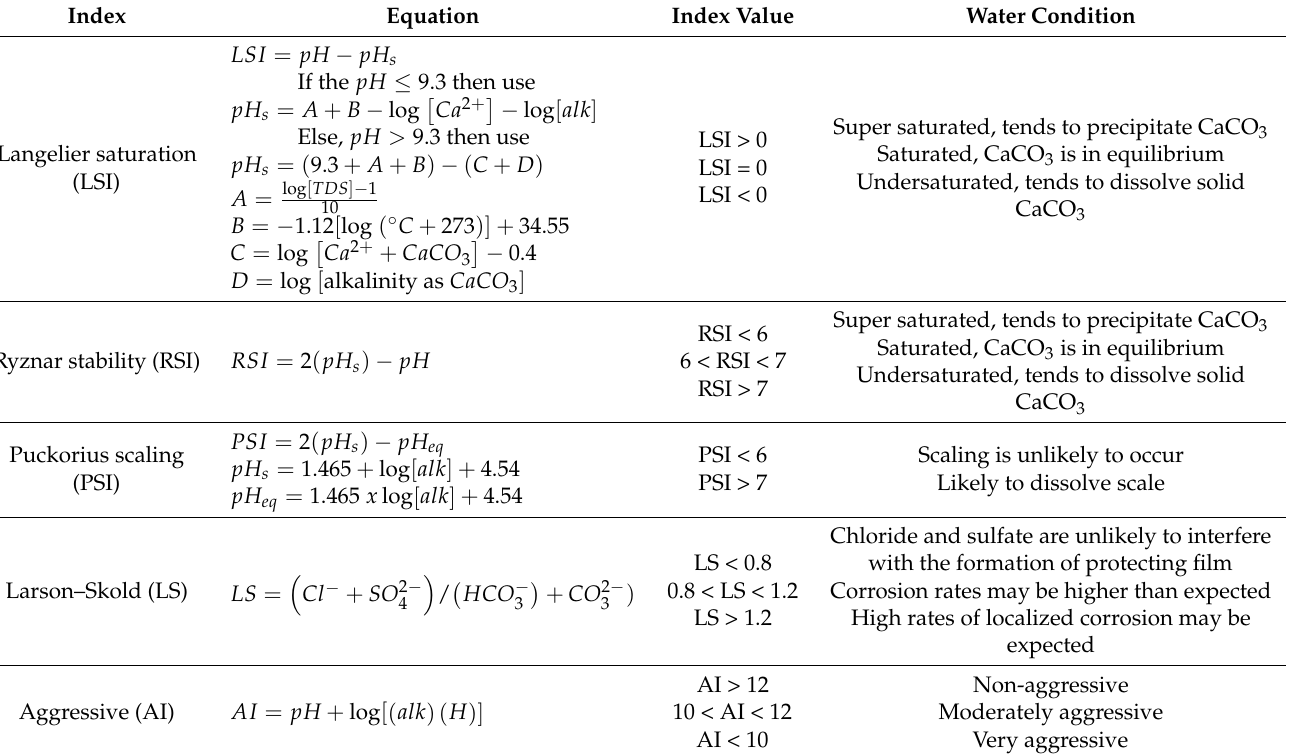
Table 1. Saturation indexes, equations, and criteria for categorizing the stability of the